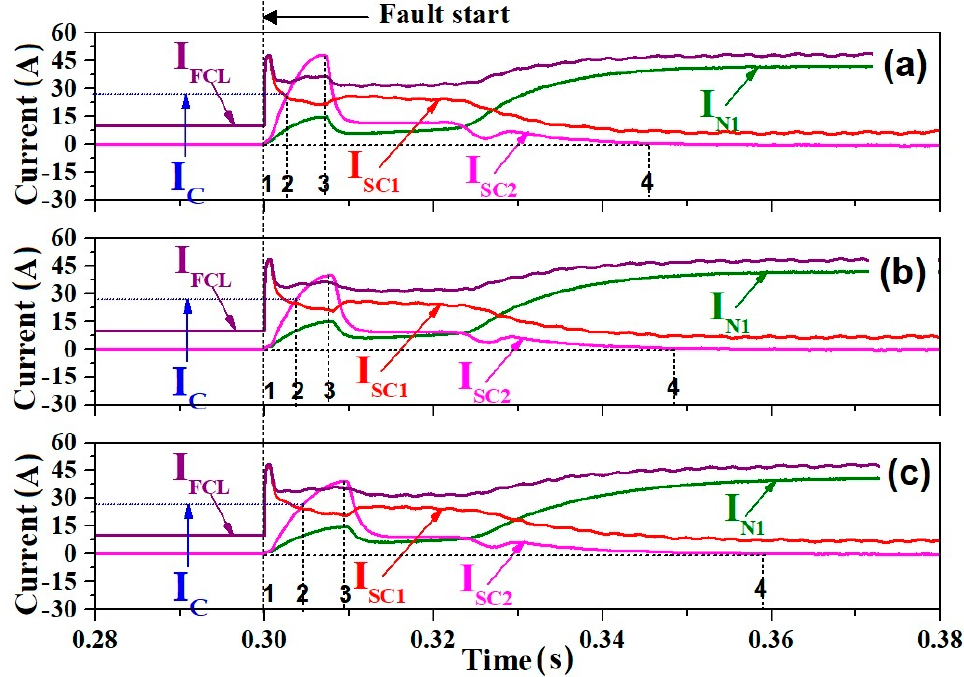
Figure 7. Current waveforms due to the CLR’s inductance: ( a ) L S = 6.6 mH; ( b ) L S = 7.5 mH; ( c ) L S = 10 mH.